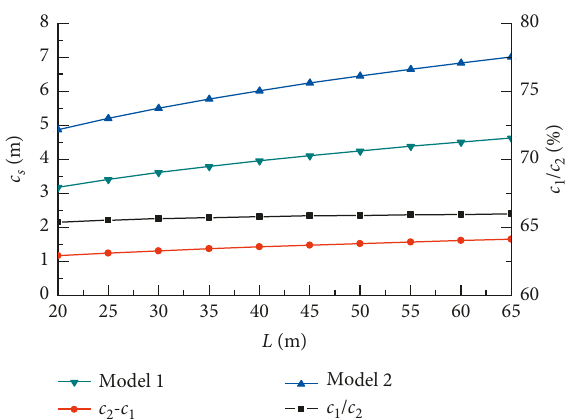
Figure 9: Diagram of minimum thickness with the mining room length.